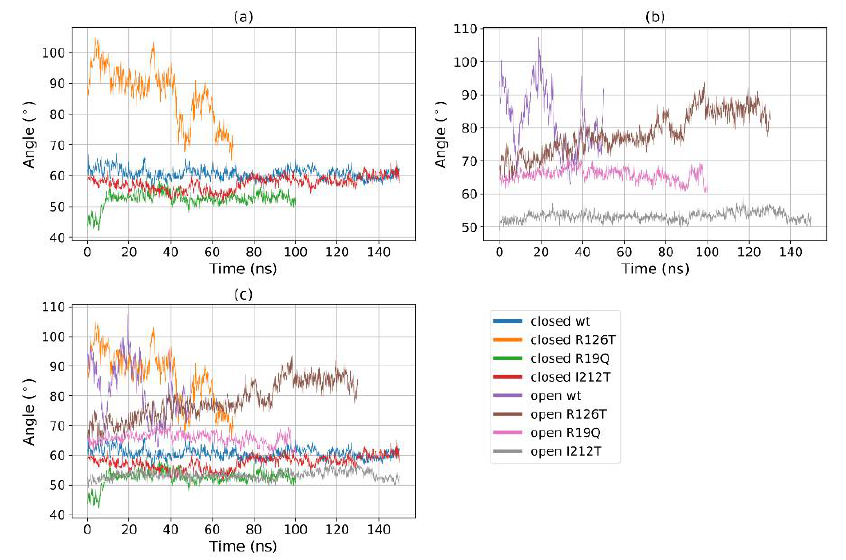
Figure 7. The Angle between the centers of geometries of domains I–II–III over time for ( a ) all the systems; ( b ) closed systems and ( c ) open